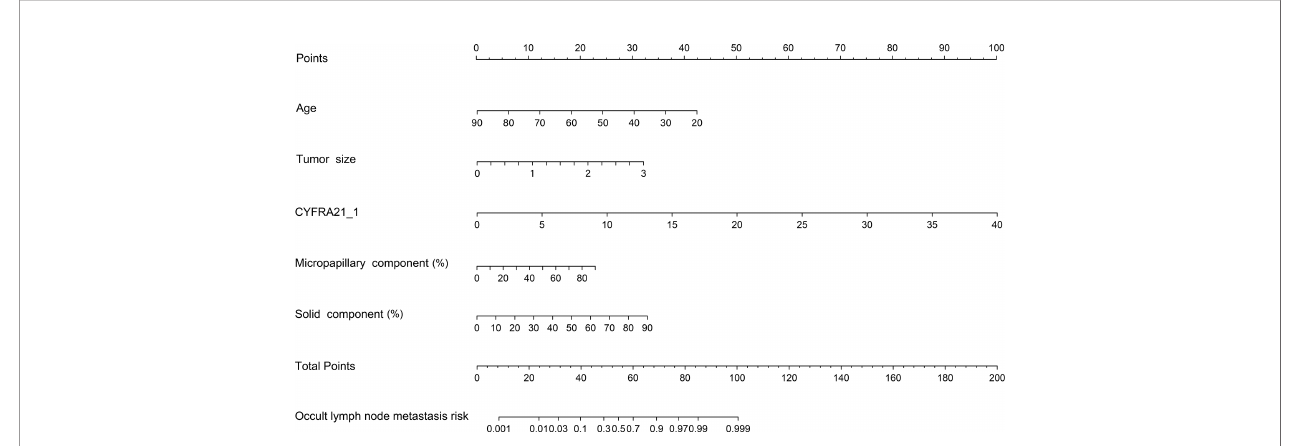
FIGURE 3 | Nomogram model predicting the occult lymph node metastasis risk in stage 1a-c patients with lung adenocarcinoma. CYFRA21-1, cytokeratin fragment antigen